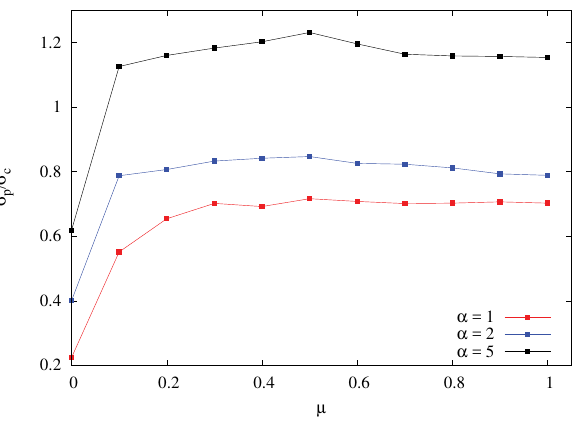
Figure 4. Normalized peak strength as a function of friction co- e ffi cient between primary particles for three di ff erent values of size ratio α